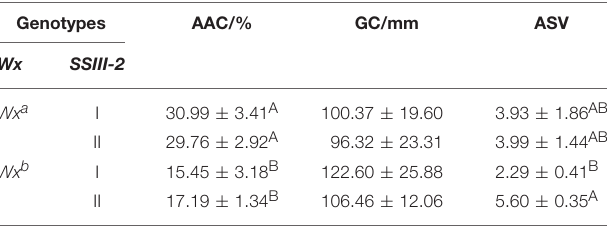
TABLE 3 | Comparison of RVA profile characteristics among different combinations of Wx and SSIII-2